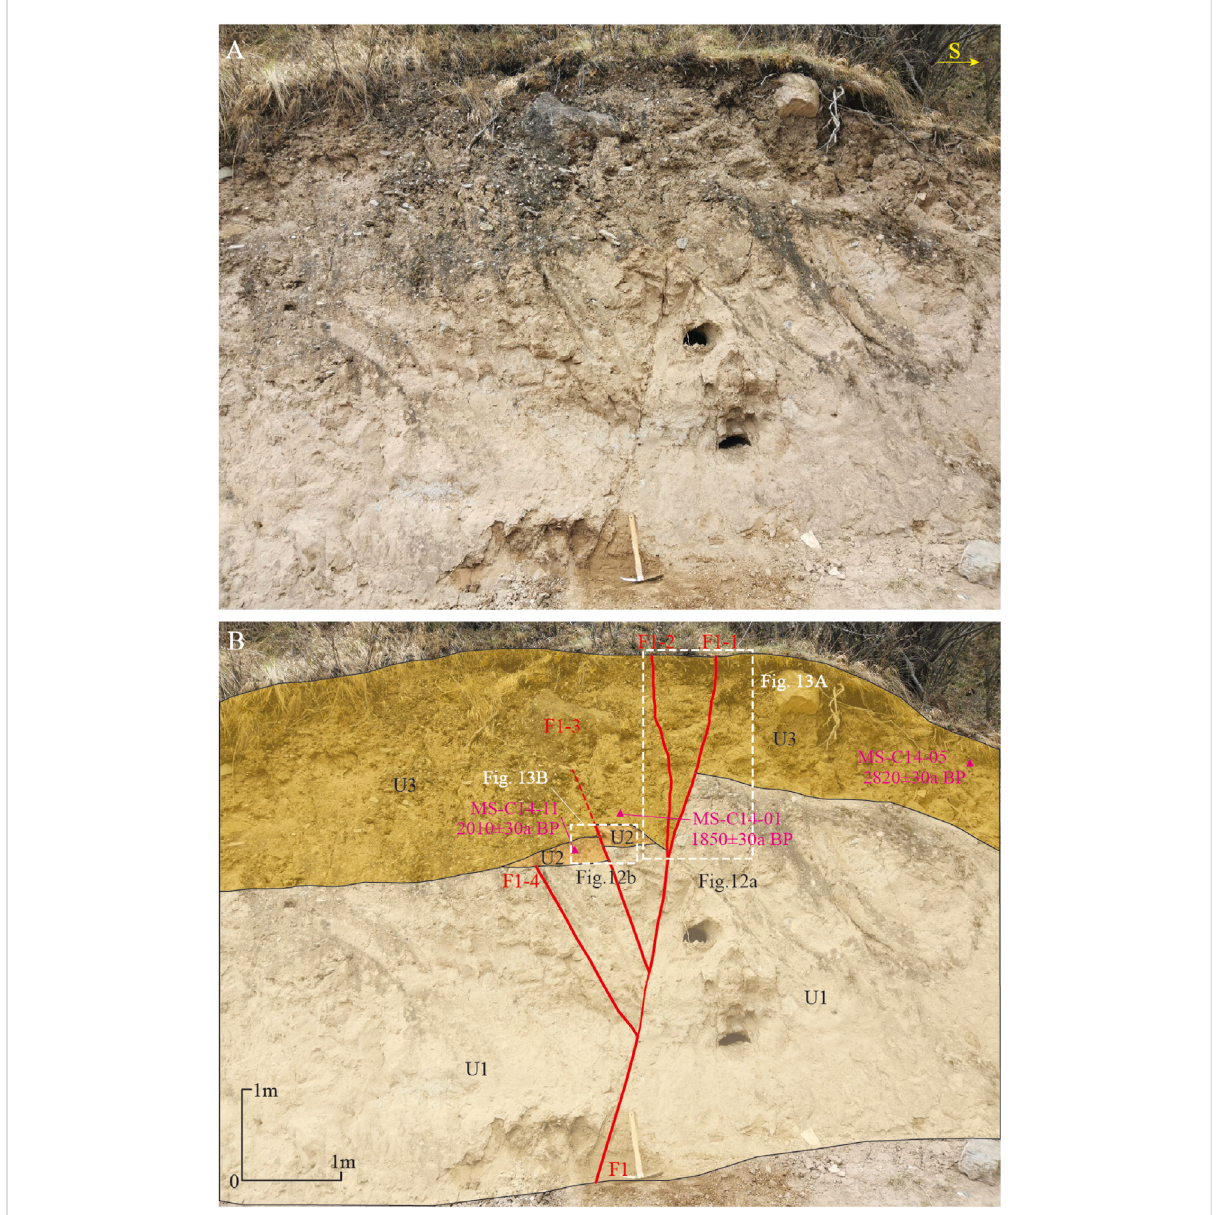
FIGURE 12 Fault outcrop of the Maisu fault near Yongqu, close to Gangtuo (E98.51321 ° , N31.71495 ° ). According to the dating results of samples collected from the strata dislocated by the fault, the Maisu fault is a Holocene-active fault. (A) Photograph showing the fault outcrop. (B) Interpretation of the fault outcrop and the locations of the dating